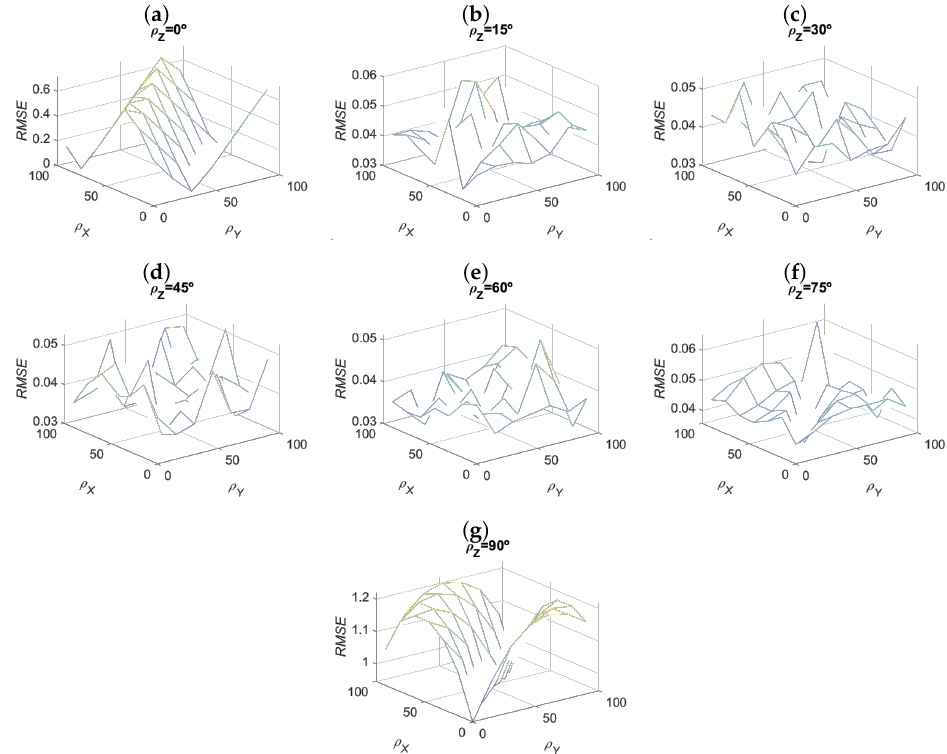
Figure 7. RMSE calculated for each calibration plane configuration of wide neural network regressor. Given the number of variables to represent, it was necessary to separate the representation into multiple graphs for the different values of ρ Z : ( a ) ρ Z = 0 ◦ , ( b ) ρ Z = 15 ◦ , ( c ) ρ Z = 30 ◦ , ( d ) ρ Z = 45 ◦ , ( e ) ρ Z = 60 ◦ , ( f ) ρ Z = 75 ◦ and ( g ) ρ Z = 90 ◦